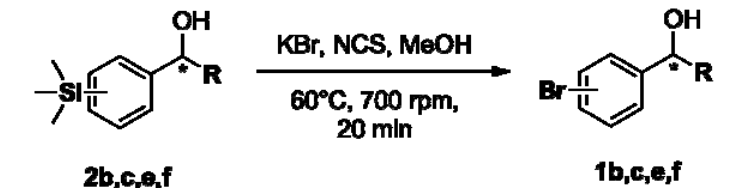
Figure 5. Bromodesilylation of enantioenriched compounds 2b , 2c , 2e and 2f